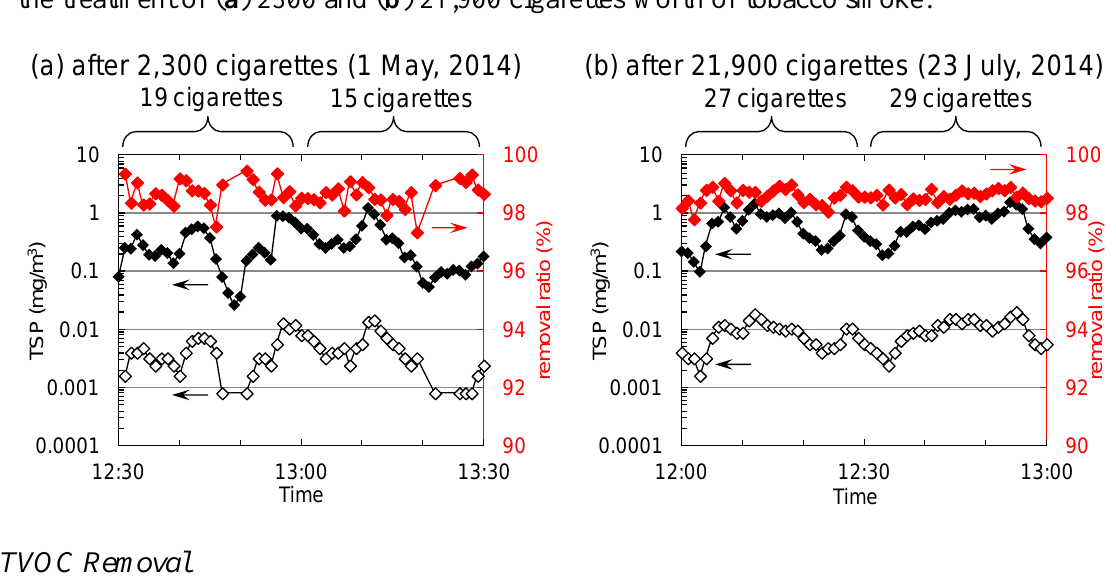
Figure 5. TSP concentrations at sampling points 1 (black filled diamonds, Figure 2) and 2 (black open diamonds, Figure 2) and the removal ratios of TSPs (red filled diamonds) after the treatment of ( a ) 2300 and ( b ) 21,900 cigarettes-worth of tobacco